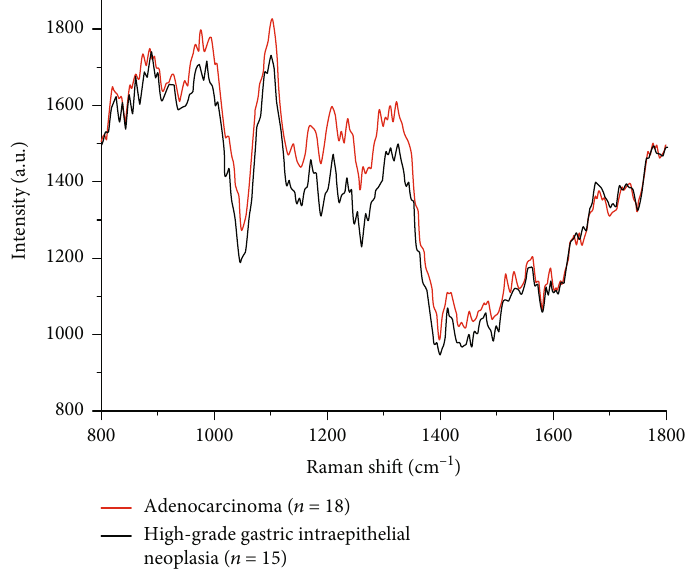
Figure 6: Mean Raman spectra of 18 adenocarcinoma tissue specimens (red line) and 15 HGIN tissue specimens (black